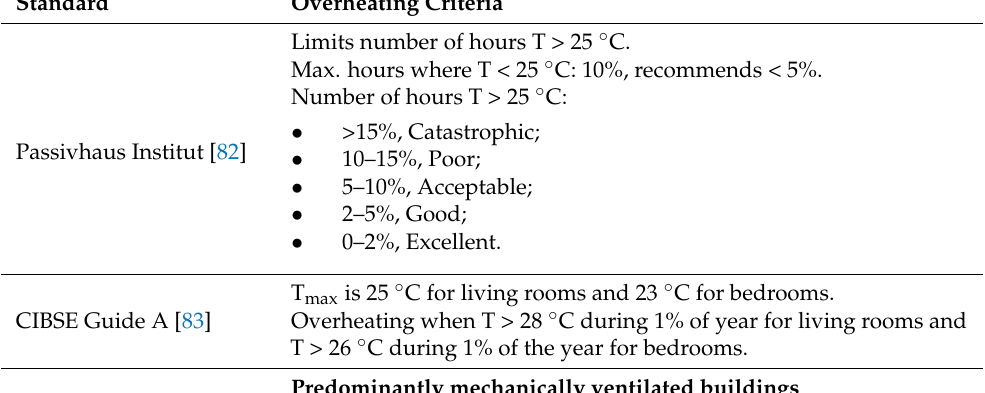
Table 5. Summary of fixed-threshold and adaptative model thermal comfort standards. Retrieved from